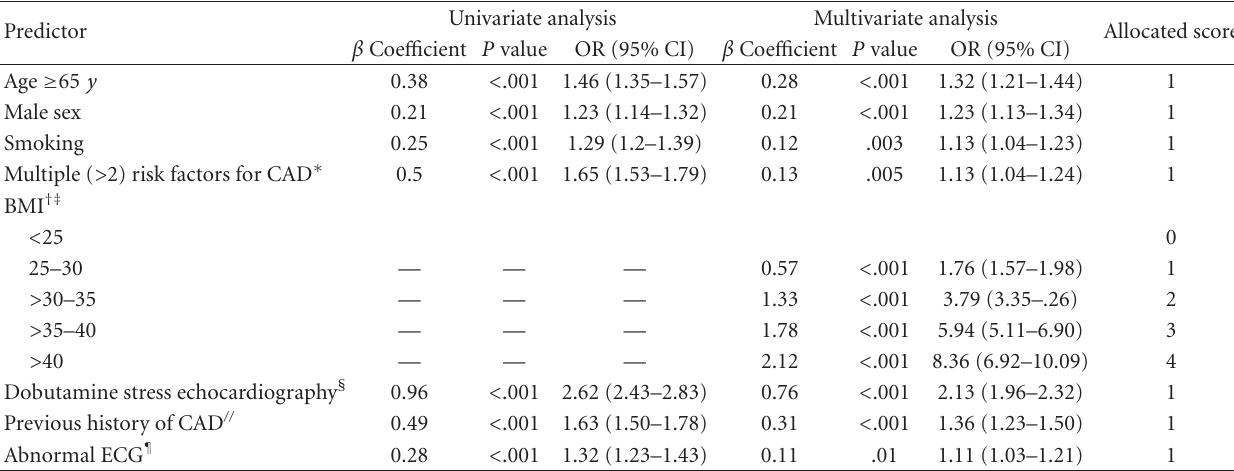
Table 2: Significant predictors of contrast agent use included in the final score model and the allocated score values.